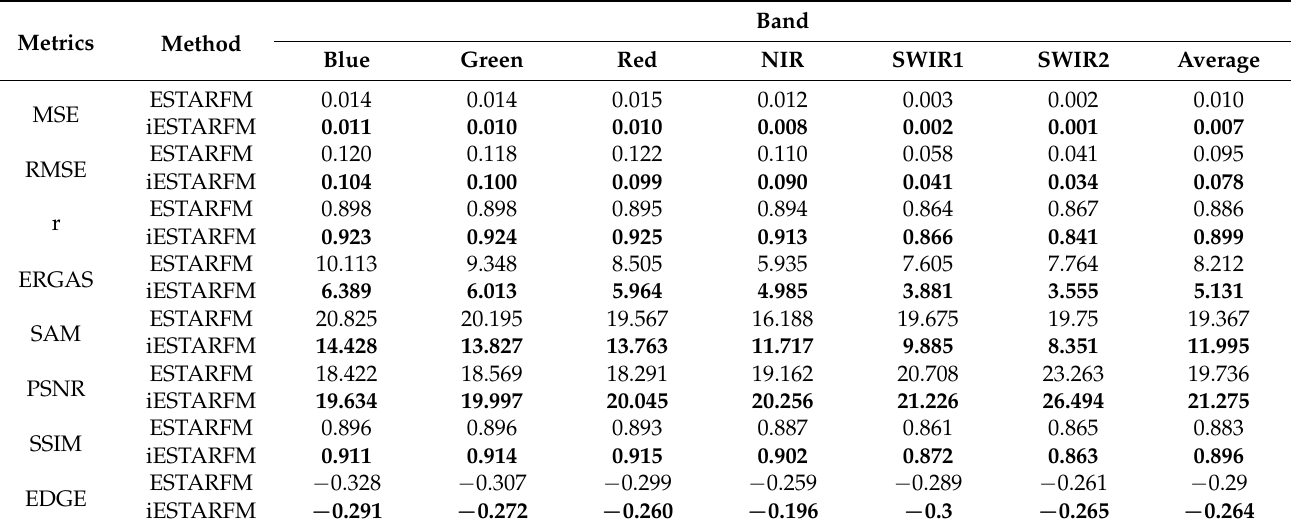
Table 4. Accuracy assessment of the ESTARFM and iESTARFM